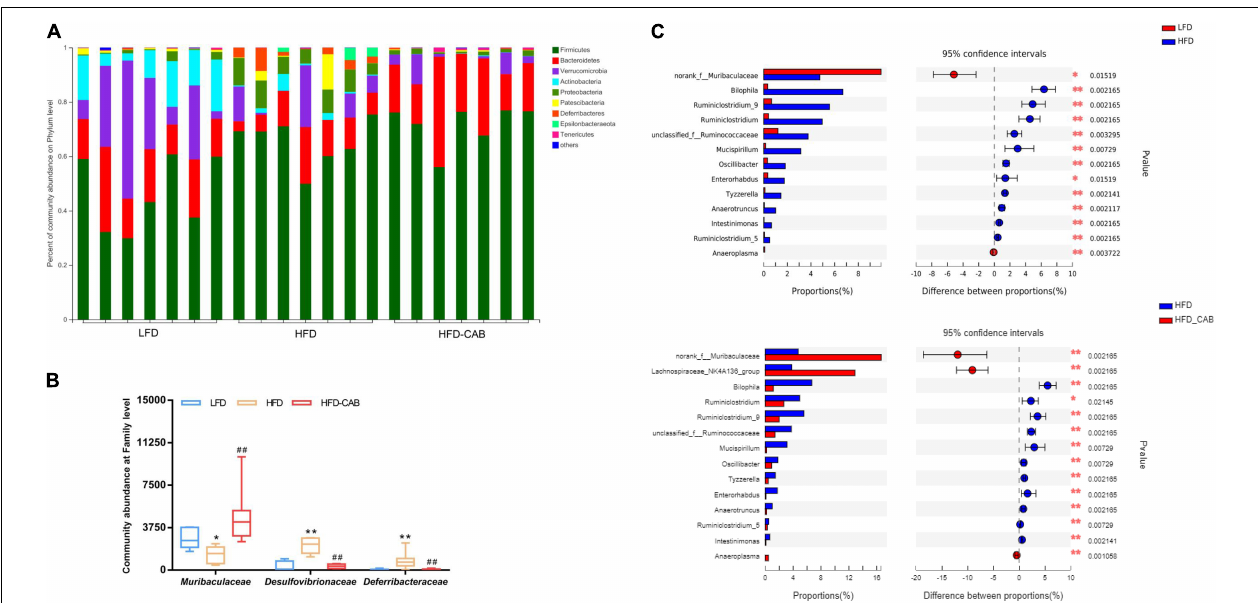
FIGURE 6 | Cooked adzuki bean modulates microbial taxonomic profiles in HFD-fed mice. (A) Bacterial profile at the phylum level, (B) Relative abundance of Muribaculaceae, Desulfovibrionaceae , and Deferribacteraceae at the family level, and (C) Mean proportions of key genera in different groups. Data presented as mean ± SEM, n = 7 per group. * P < 0.05 and ** P < 0.01 vs. LFD; ## P < 0.01 vs. HFD (B). * P < 0.05 and ** P < 0.01 (C) . LFD, low-fat diet; HFD, high-fat diet; HFD-CAB, high-fat diet supplemented with cooked adzuki bean.